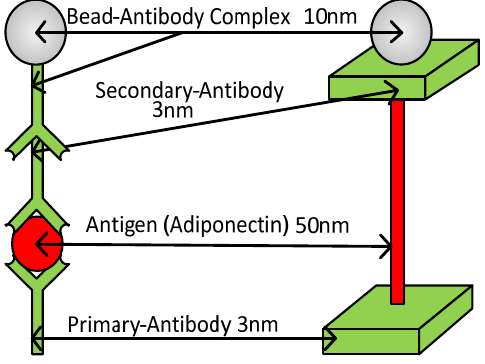
Figure 1. Mechanical model of a superparamagnetic nanoparticle––protein complex.